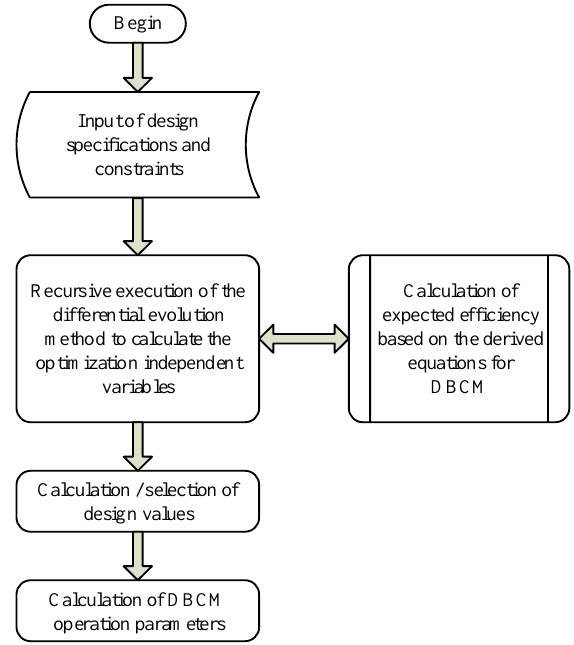
Figure 4. Flowchart of the design process.